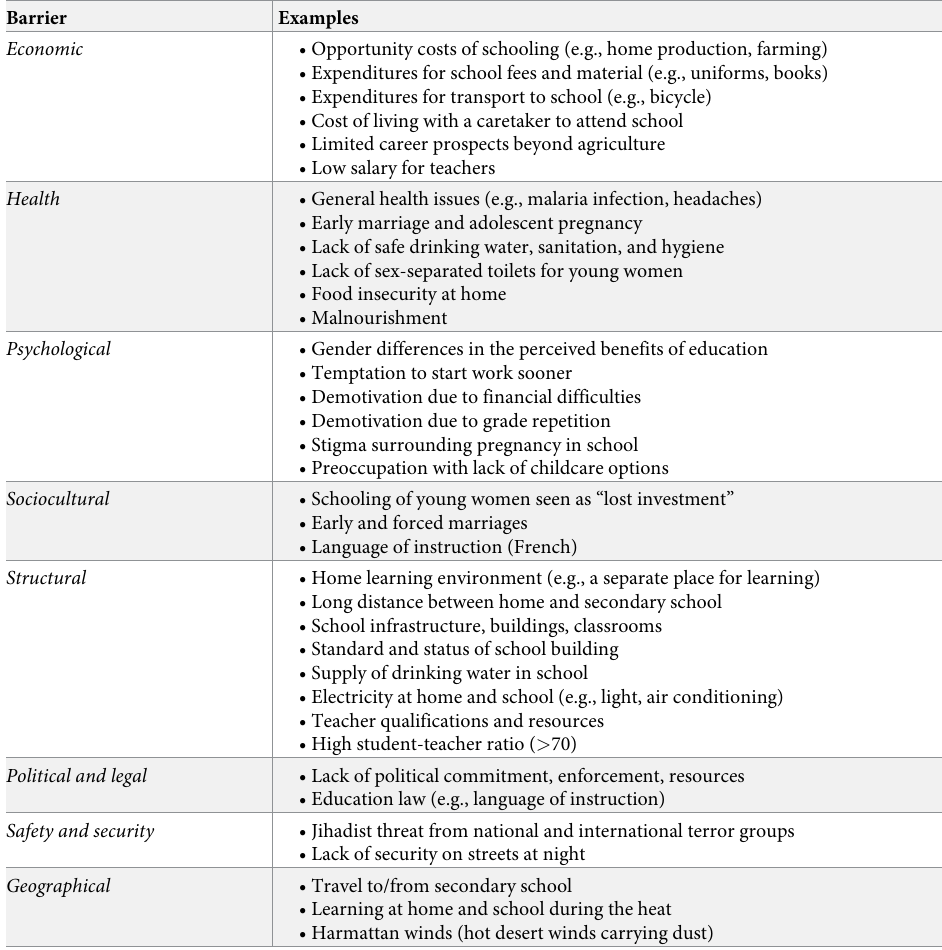
Table 2. Barriers to secondary schooling reported in rural Burkina